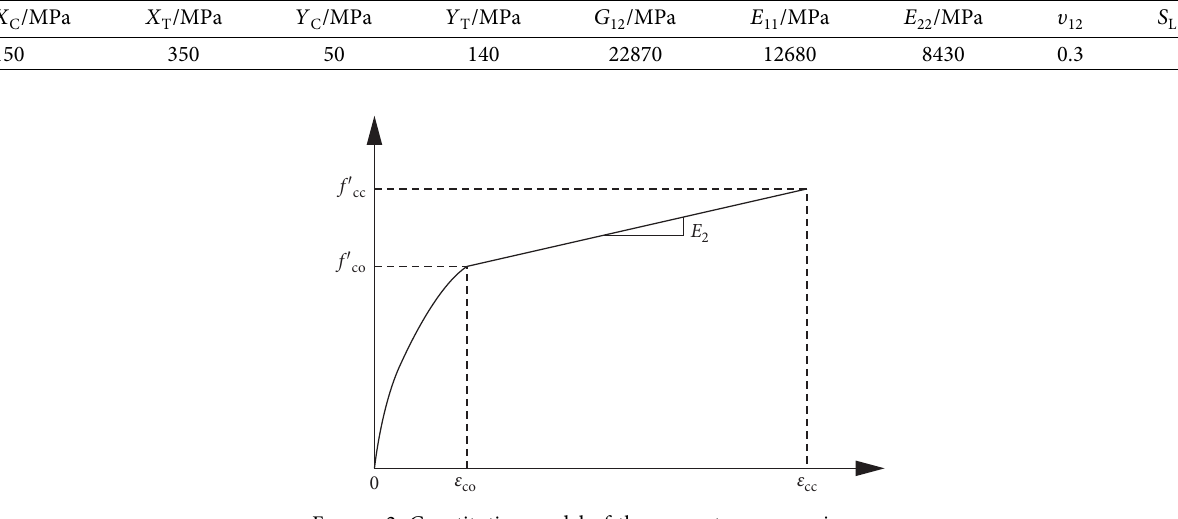
Figure 2: Constitutive model of the concrete compression zone.